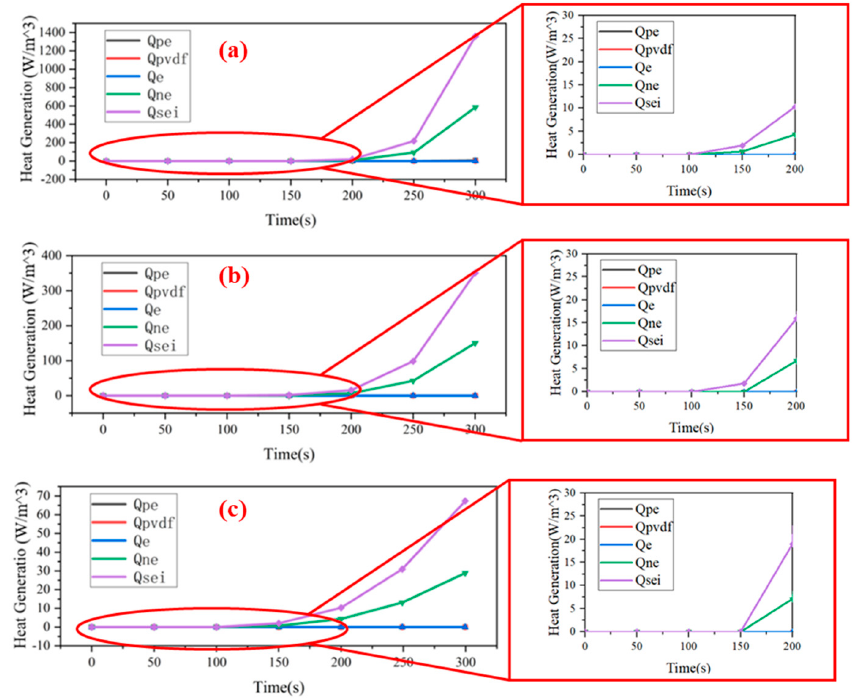
Figure 5. Heat production curves for each component in tests 4, 5, and 6: ( a ) 423.15 K; ( b ) 473.15 K; and ( c ) 523.15 K. and ( c ) 523.15